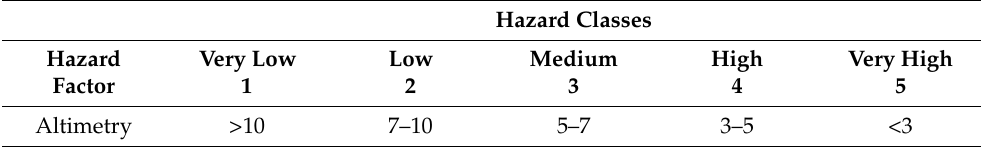
Table 3. Hazard classification concerning the altimetry hazard factor.